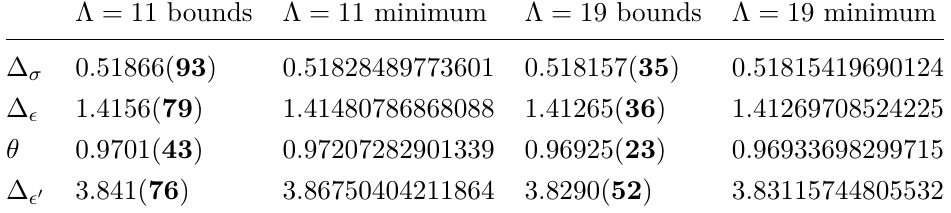
Table 3 . Allowed interval found at Λ = 11 and 19 using the N (∆ (cid:15) , ∆ σ , θ, ∆ (cid:15) 0 ) navigator where we assume ∆ 3 and ∆ 6 . The error presented in bold is rigorous. The second and fourth σ 0 > (cid:15) 00 > column give the location of the minimum at Λ = 11 and 19 respectively.